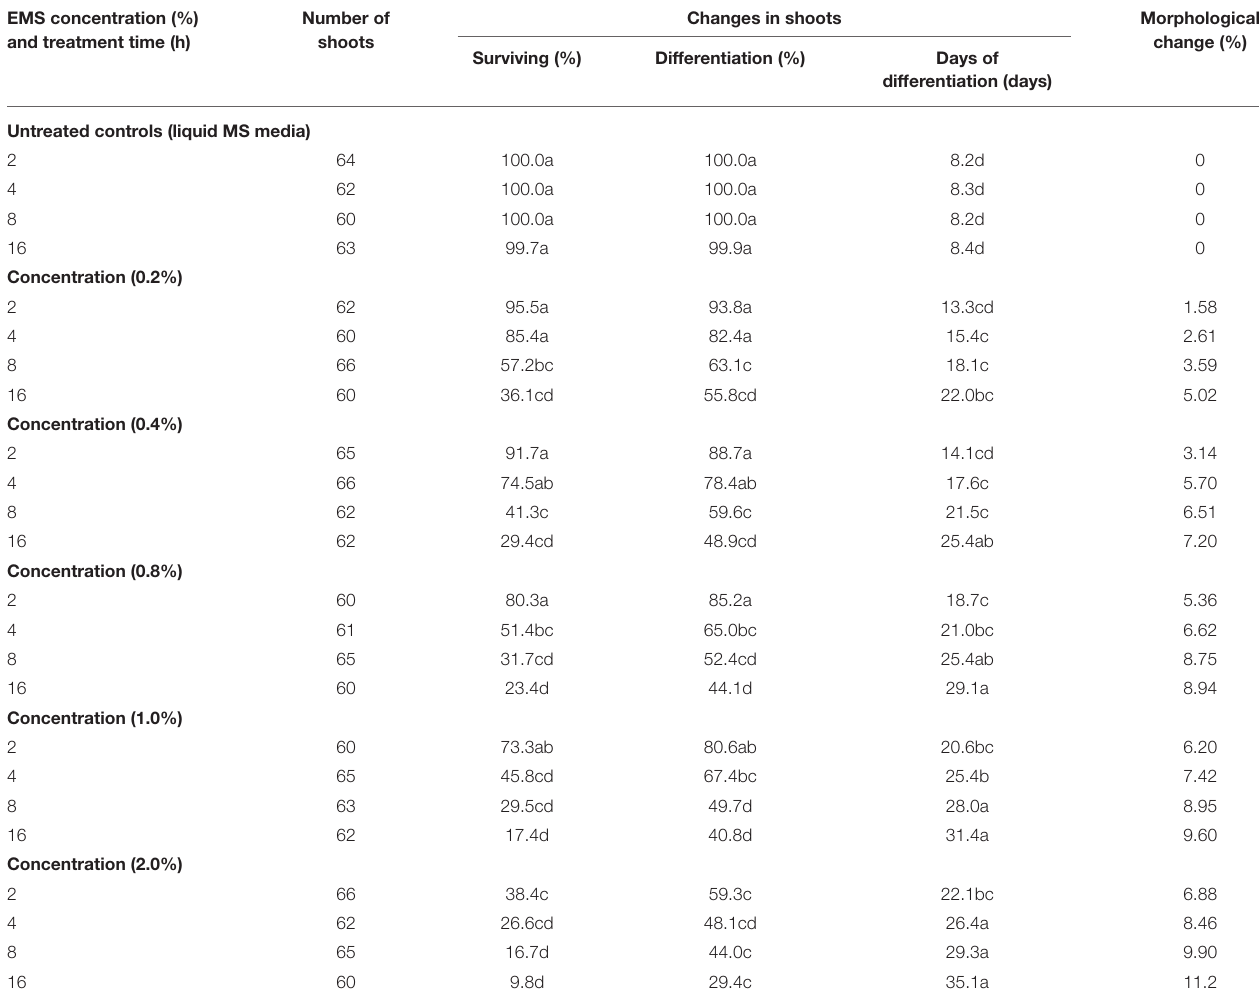
TABLE 1 | Banana shoot growth and development after treatment with EMS. EMS concentration (%) and treatment time